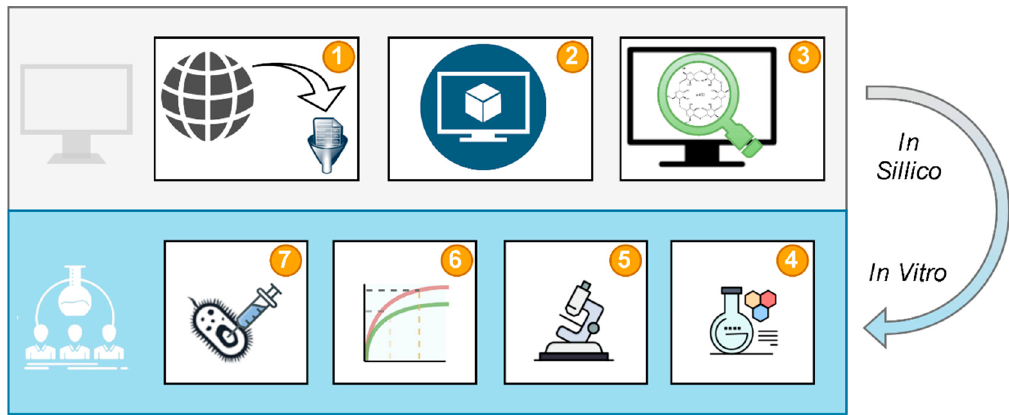
Figure 2. Study design: Data curation ( 1 ), model development ( 2 ), virtual screening ( 3 ), system preparation ( 4 ), characterization ( 5 ), dissolution tests ( 6 ), and antimicrobial efficacy tests ( 7 ).